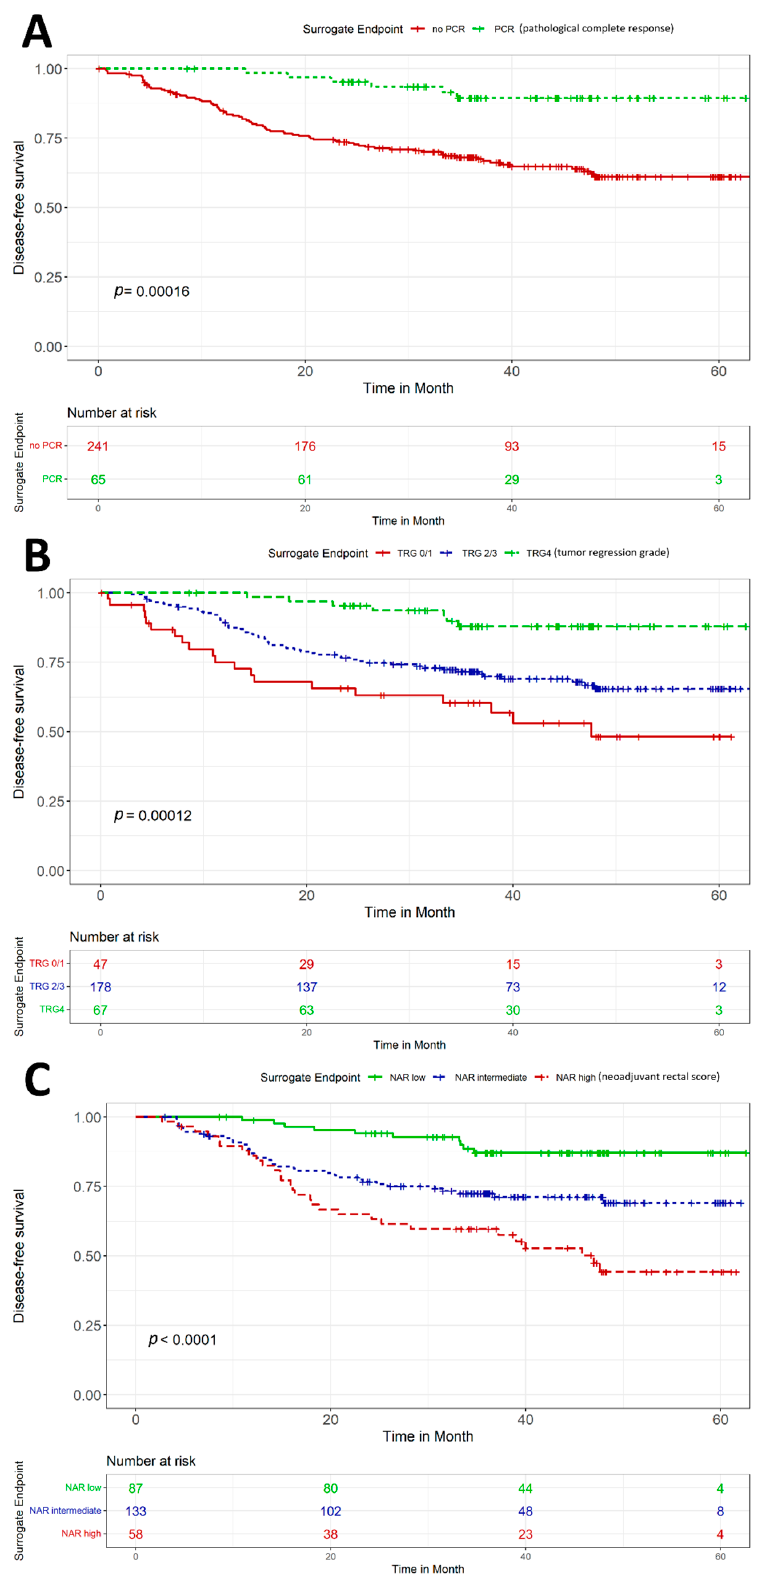
Figure 1. Prognostic significance of pCR ( A ), TRG ( B ) and NAR score ( C ) for disease-free survival. The log-rank test was used to assess statistical significance. The statistical test was two-sided.